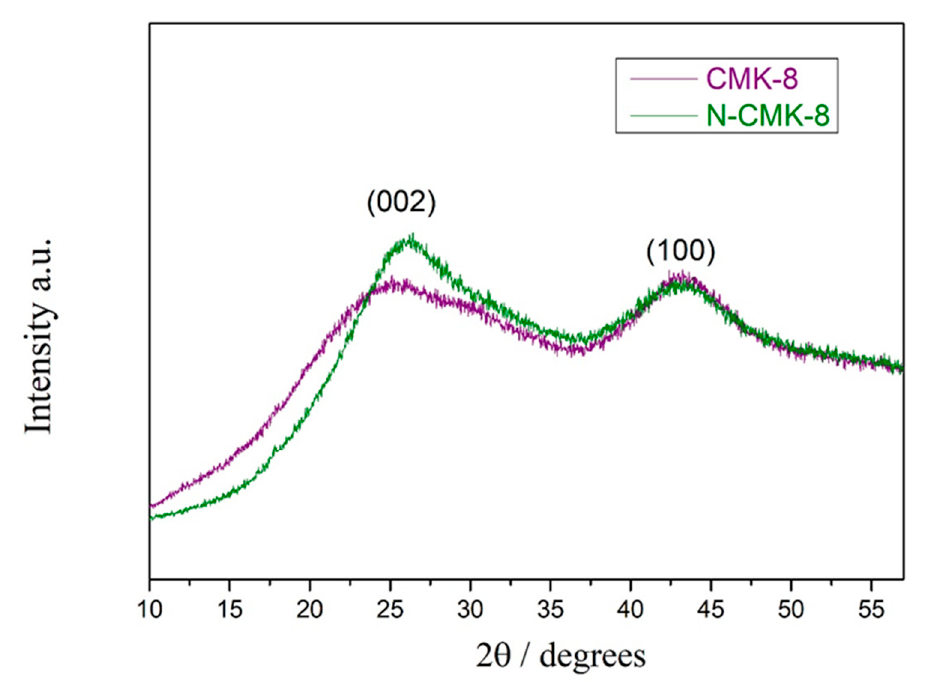
Figure A1. X-ray di ff raction patterns of CMK-8 (purple line) and N-CMK-8 (green line). The peaks are Figure A1. X-ray diffraction patterns of CMK-8 (purple line) and N-CMK-8 (green line). The peaks indexed with the respective Miller are indexed with the respective Miller index.